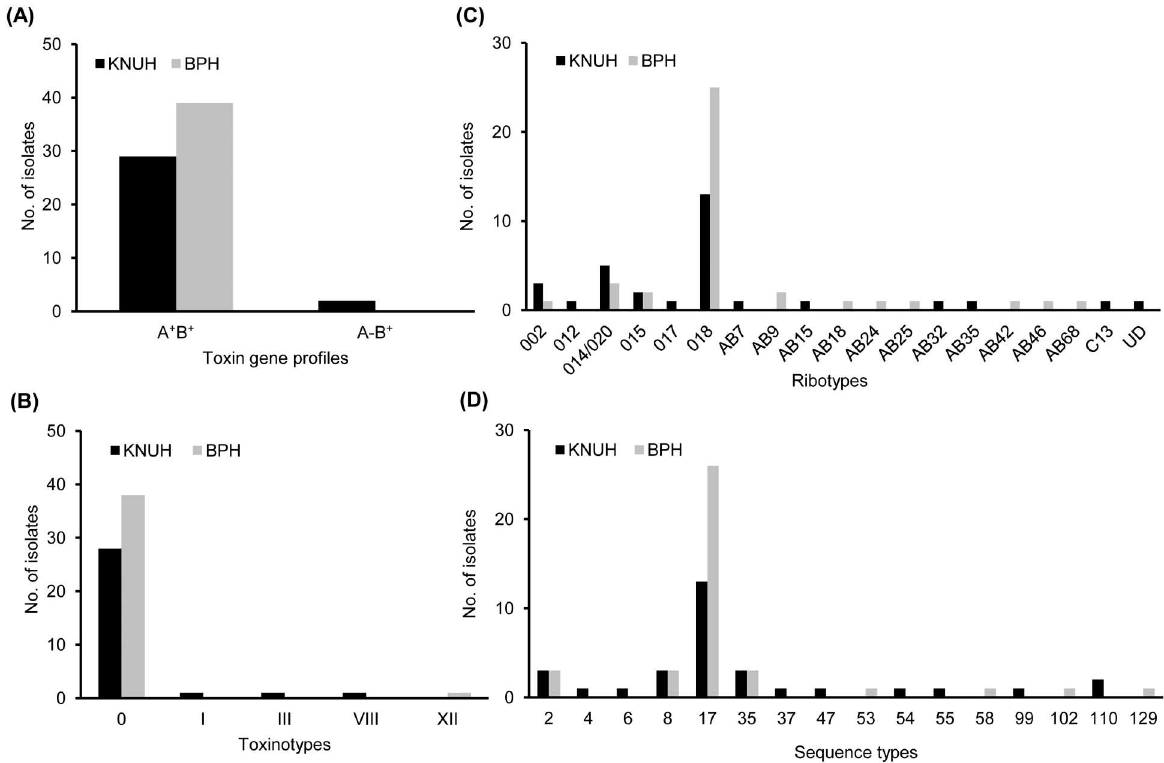
Fig 1. Distribution of toxin gene profiles (A), toxinotypes (B), PCR ribotypes (C), and sequence types (D) among 70 C . difficile isolates from two Korean hospitals. In Fig 1C, UD means that the isolate was not assignedto any knownribotype.KNUH, Kyungpook NationalUniversity Hospital;BPH, Busan Paik